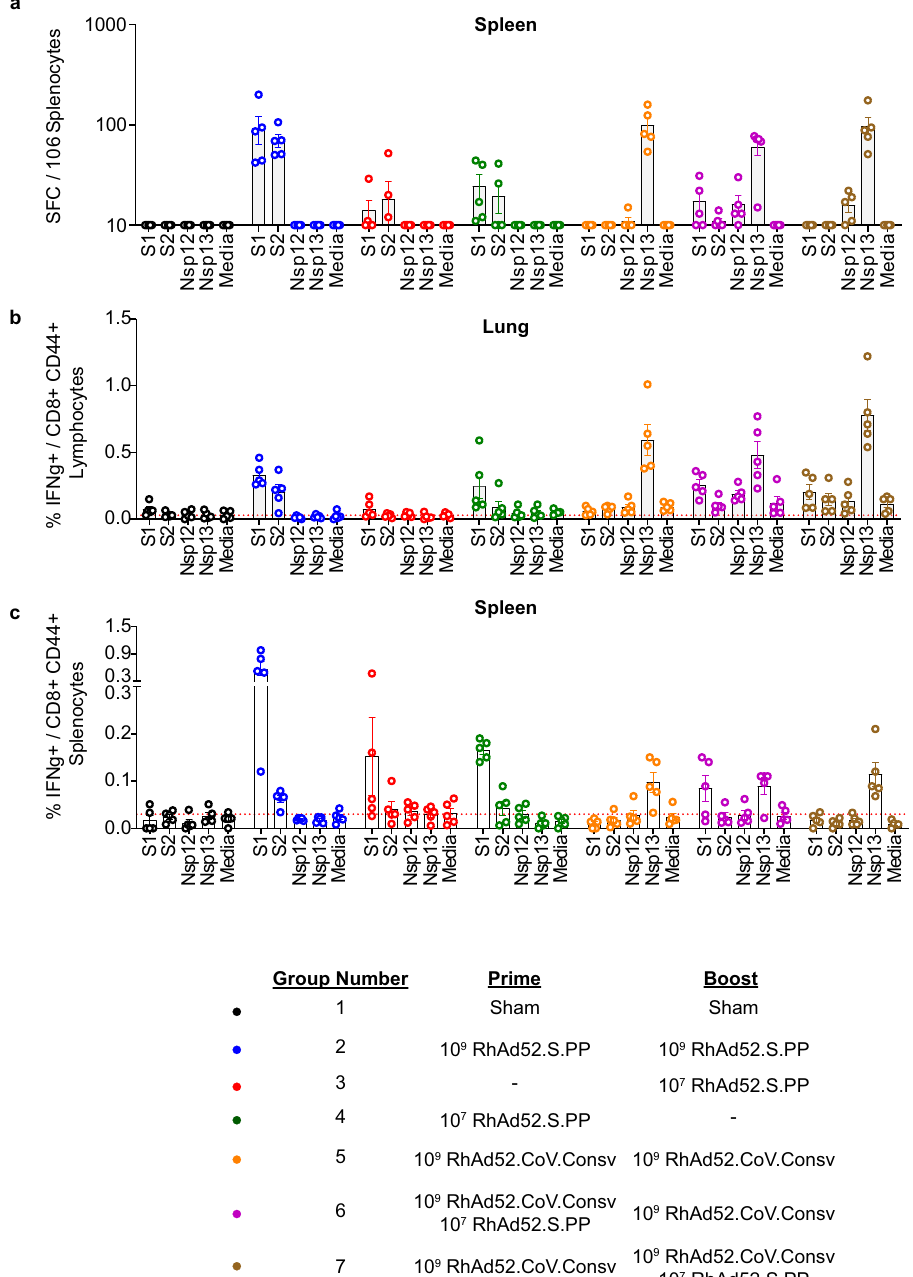
Fig. 4 Antiviral cellular immunity elicited by multiple RhAd52.CoV.Consv prime / boost regimens in BALB/c mice. a – c Antiviral cellular immunity as measured by IFN γ ELISpot (A) and IFN γ -secreting CD8 + CD44 + T cells in isolated lung ( b ) and spleen ( c ) tissue from BALB/c mice immunized with the designated prime RhAd52 vaccine, boosted with the corresponding RhAd52 vaccine 4 weeks later, and sampled 4 weeks following the boost (8 weeks following the prime immunization). Individual mice are denoted by single dots with bars displaying the mean ± the SEM. Gating strategy and representative fl ow plots are found in Supplementary Figs. 1 –